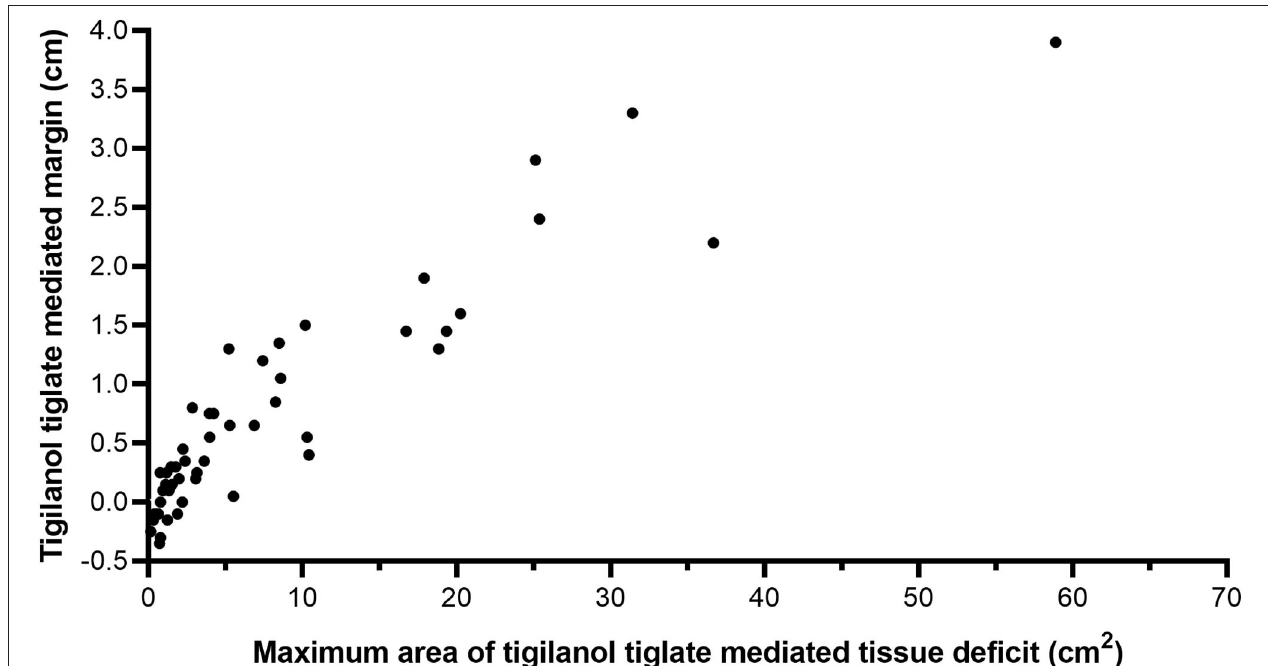
FIGURE 2 | Scatter plot showing the relationship between maximum area of tissue deficit and the TT-mediated margin for 51 dogs that were recurrence free 12 months after a single intratumoural treatment of a mast cell tumour (MCT) with TT. Linear regression adjusted R 2 = 0.84, using equation TT mediatedmargin (cm) = 0.11 + 0.08 X [TT TissueDeficit (cm 2 ) ], power function R 2 = 0.87, using equation. TT mediatedmargin (cm) = 0.18 X [TT TissueDeficit (cm 2 ) ] 0.77